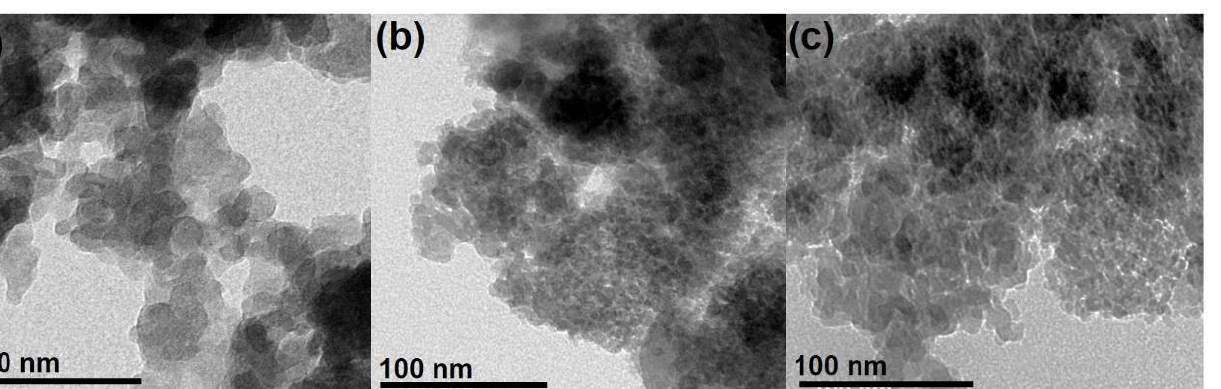
Figure 2. Thermogravimetric analysis of SiO 2 before and after rice husk (RH) treatment at 600 ◦ C. TEM images of commercial and synthetic SiO 2 are illustrated in Figure 3. The for- mer comprises well-separated, quasi-spherical nanoparticles with an average diameter of around 15–16 nm. On the other hand, small particle sizes (5–10 nm) compared to AC were observed concerning SG and RH. As for SG, the formation of tiny particles was most likely favored by the large H 2 O/NH 3 ratio used during the synthesis. In addition, water triggers TEOS hydrolysis, generating plenty of nuclei in the initial reaction stages. Conversely, the limited amount of ammonia keeps the nuclei from growing. Concerning RH, particle size is mainly determined by the annealing temperature. Usually, 600 ◦ C is considered an efficient trade-off between high reactivity assured by small particle (i.e., large specific surface area) size and the complete removal of organic matter [30,31,58,66].